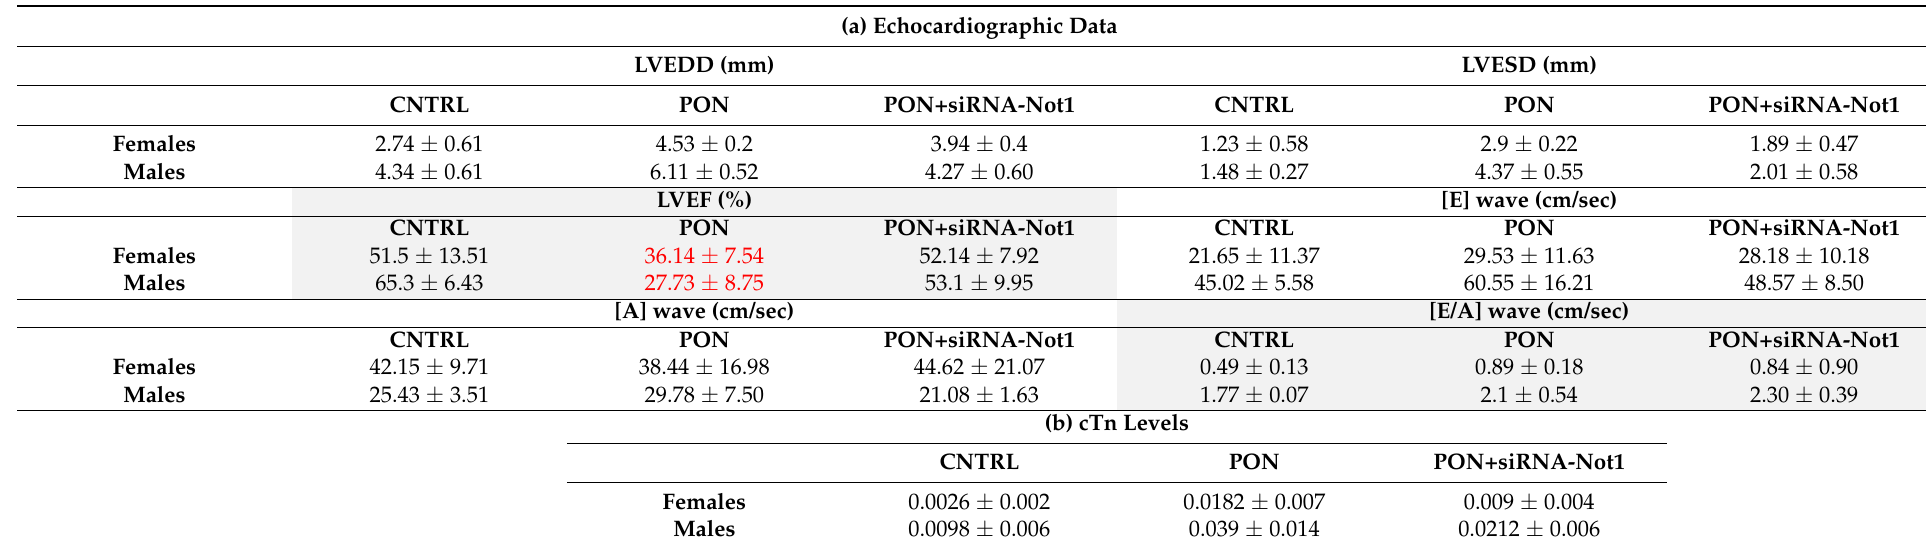
Table 1. Cardiac function